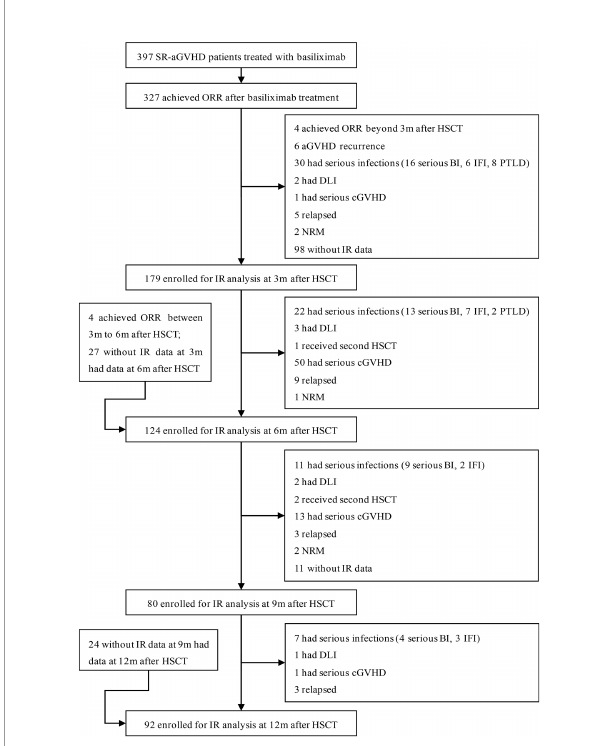
FIGURE 1 | Diagram of patients enrolled. A total of 327 SR-aGVHD patients who showed an ORR to basiliximab treatment were eligible, and 179, 124, 80, and 92 patients were included in the fi nal analysis for IR at 3, 6, 9, and 12 months, respectively, after HID HSCT. HID HSCT, haploidentical donor hematopoietic stem cell transplantation; IR, immune reconstitution; NRM, non-relapse mortality; ORR, overall response rate; SR-aGVHD, steroid- refractory acute graft-versus-host